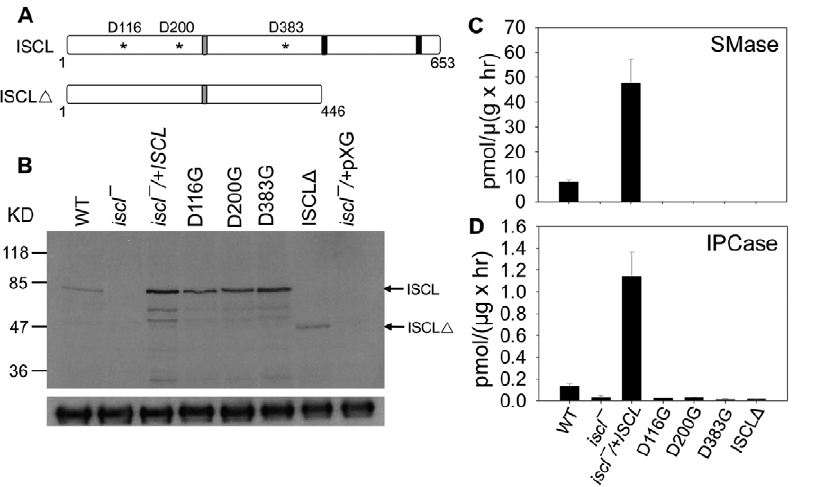
Figure 2. Functional analysis of ISCL by mutagenesis. ( A ) Schematic diagram of ISCL open reading frame and the mutations introduced in this study. Asterisks represent the three aspartic acids (D116, D200, and D383) that were mutated; grey bars represent the region recognized by the anti- ISCL peptide antibody; and black bars represent the transmembrane helices. ( B ) Western-blot to confirm the expression of mutated ISCL. Whole cell lysates from WT, iscl 2 , iscl 2 / + ISCL, iscl 2 / + ISCL D116G, iscl 2 / + ISCL D200G, iscl 2 / + ISCL D383G, iscl 2 / + ISCL D and iscl 2 / + pXG (empty vector) promastigotes were probed with either anti-ISCL (top) or anti- a -tubulin (bottom) antibody. Each lane contained material from 6 6 10 5 cells. ( C–D ) The SMase and IPCase activities in log phase promastigotes were determined as described in MaterialsandMethod . Error bars represent standard deviations from 3 independent experiments.